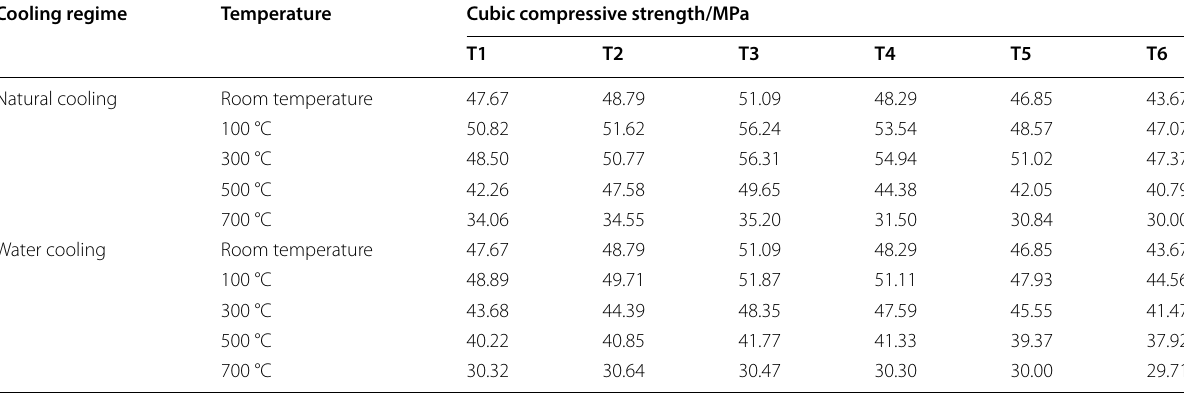
Table 2 Cubic compressive strength of concrete produced with desert sand after elevated temperature. Cooling